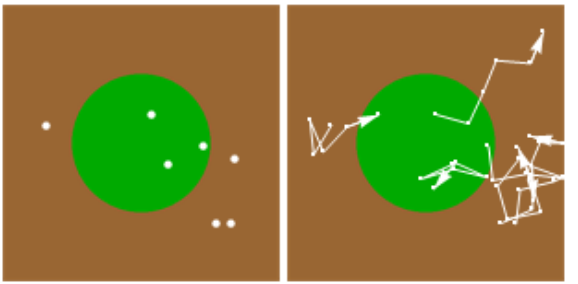
Figure 4. Setting up 7 agents and simulating their wandering through 5 epochs with step size